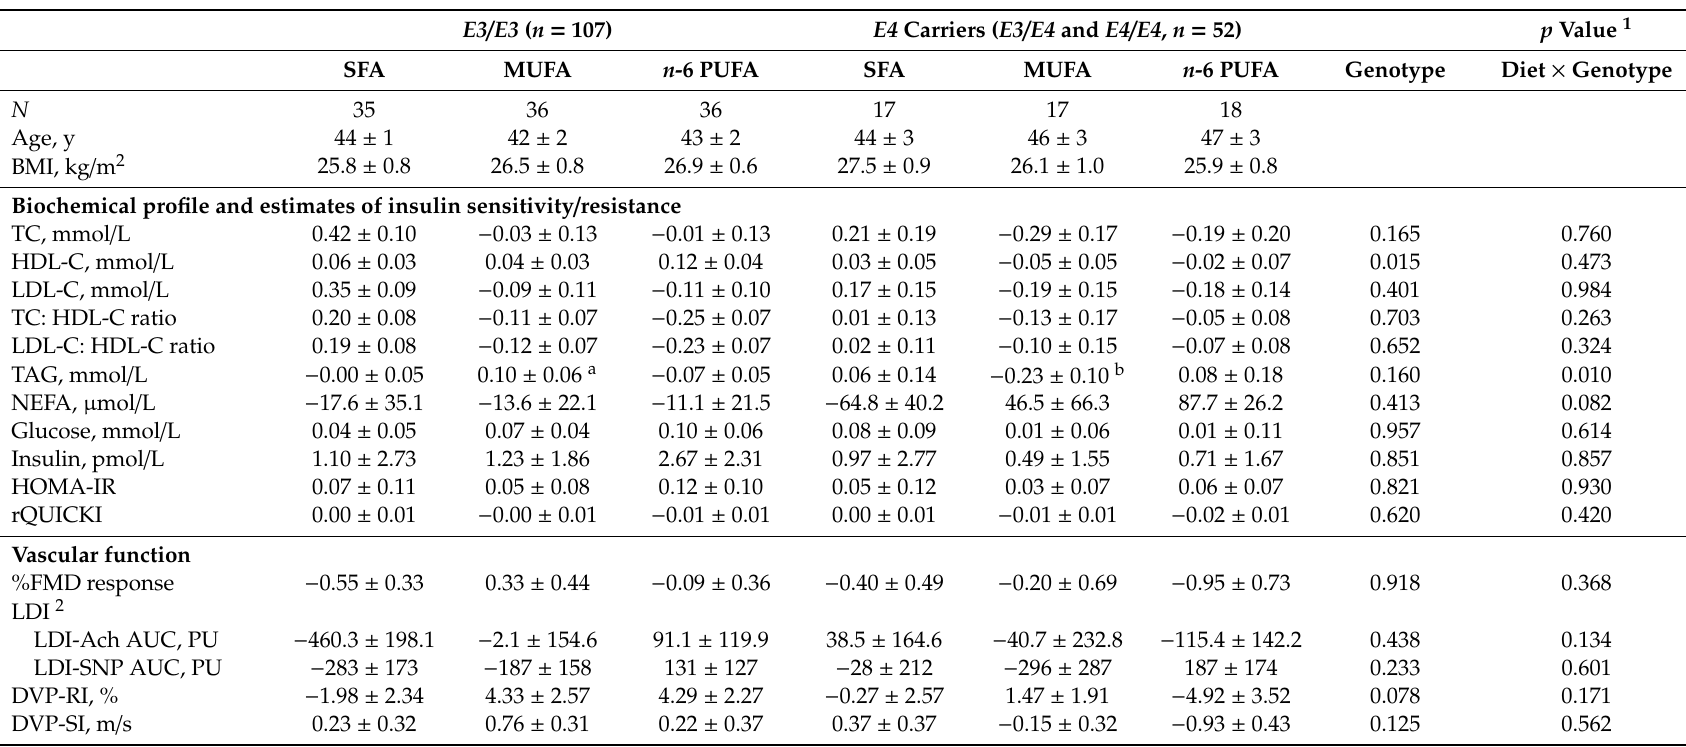
Table 2. Changes in fasting cardiometabolic risk markers after chronic dietary fat manipulation according to the APOE genotype (DIVAS